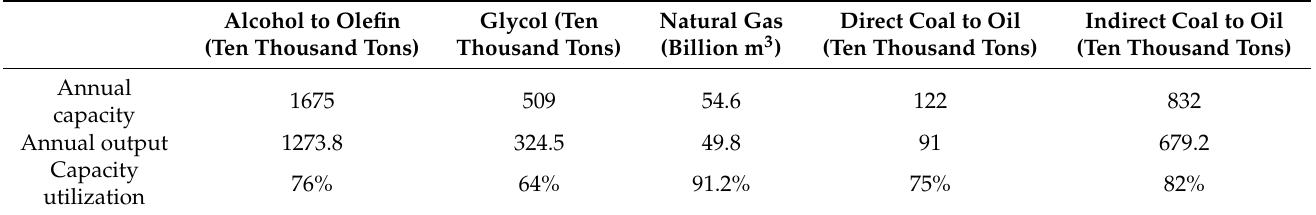
Table 4. Capacity and output of the chemical